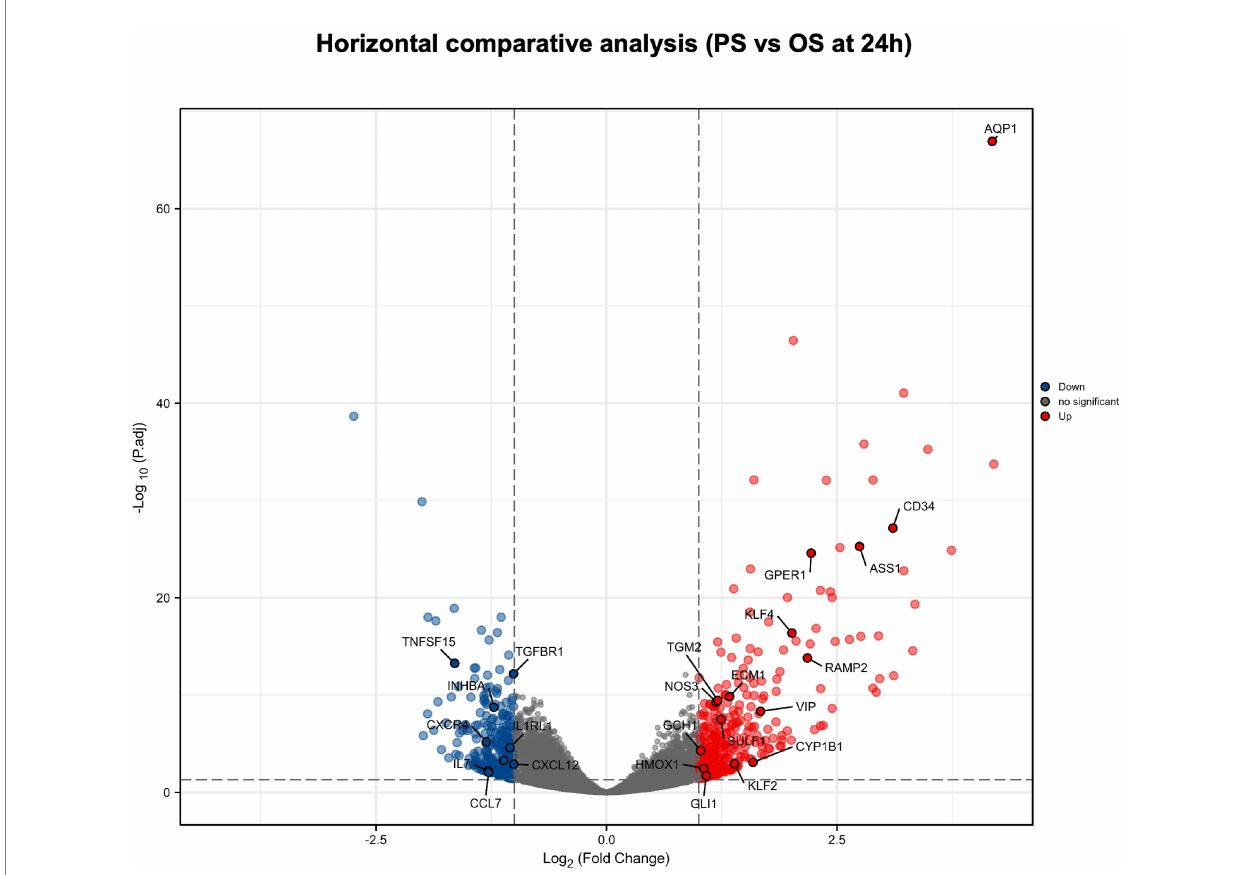
FIGURE 2 Horizontal comparative analysis of PS and OS in HUVECs mRNA. Volcano plots show the significant differences between PS and OS in HUVECs mRNA at 24 h. Each dot represents a mRNA (blue, downregulated; red, upregulated; gray, no significant). In HUVECs mRNA, the molecules with significant difference were defined as p.adj < 0.05 and |Log2 Fold